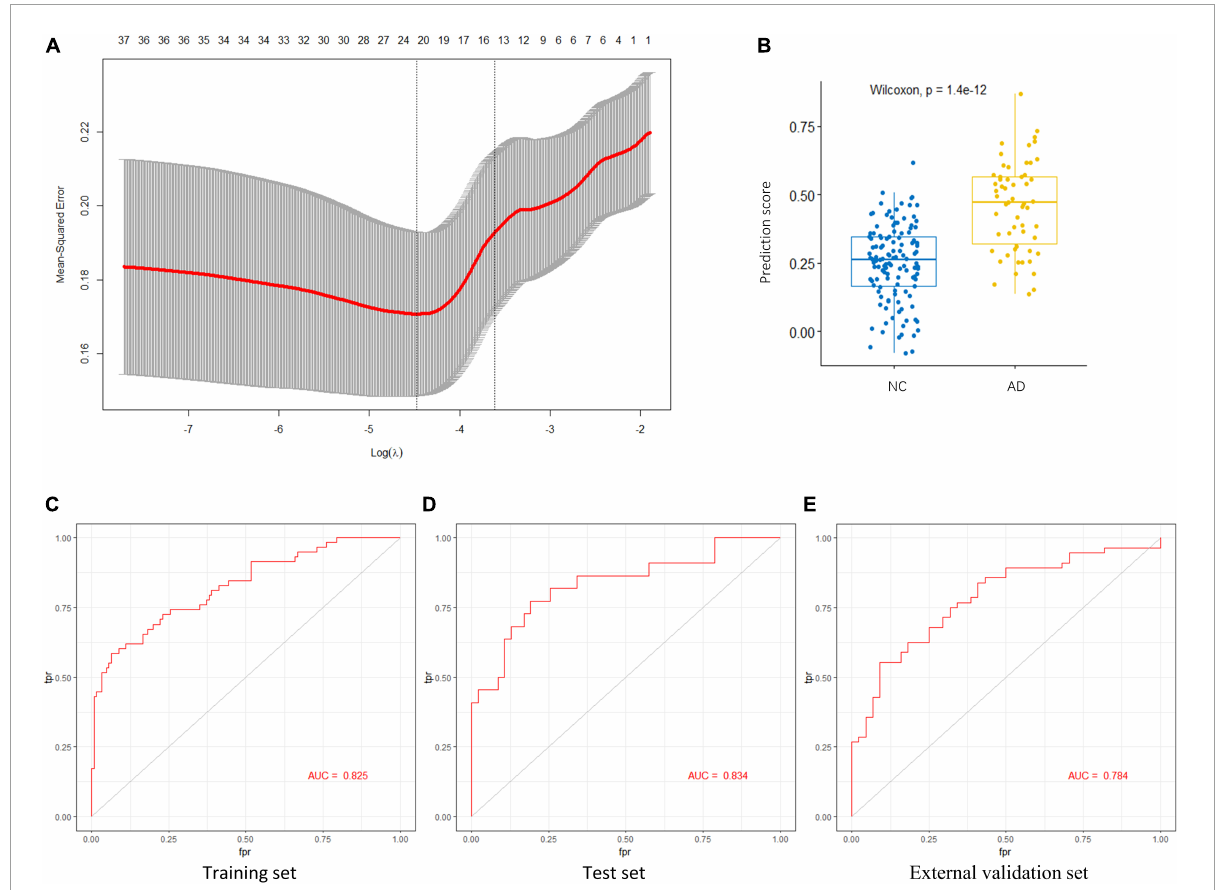
FIGURE5 Key AGs selection through the LASSO model. (A) The selection of the best lambda in the LASSO model. (B) Boxplot used to assess the performance of the prediction model. (C) The AUC was 0.825 in training set. (D) The AUC was 0.834 in test set. (E) The AUC was 0.784 in validation set GSE122063. AG, aging-related gene; AUC, area under the curve; LASSO, least absolute shrinkage and selection operator.